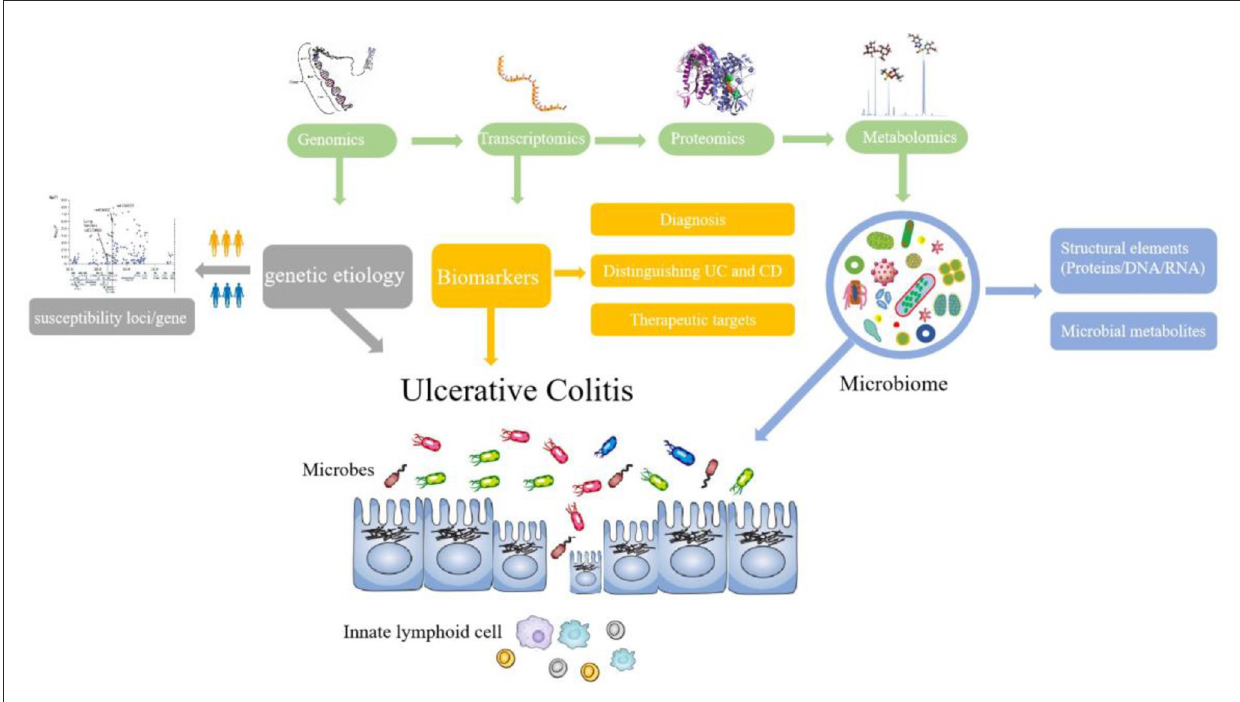
FIGURE9 Research trend of omics in